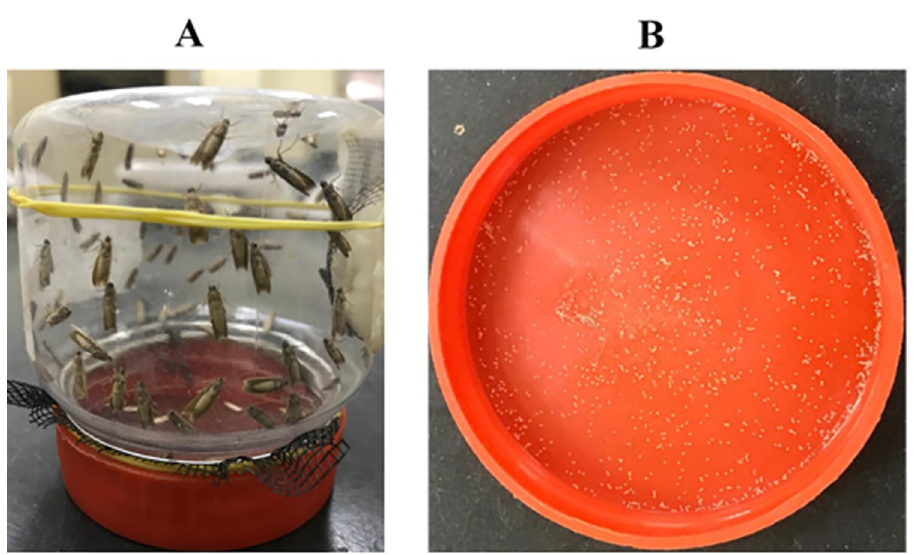
Fig 1. Mating arena and egg laying container for Cadra cautella adult moths (A) and cover containing C . cautella eggs (B).